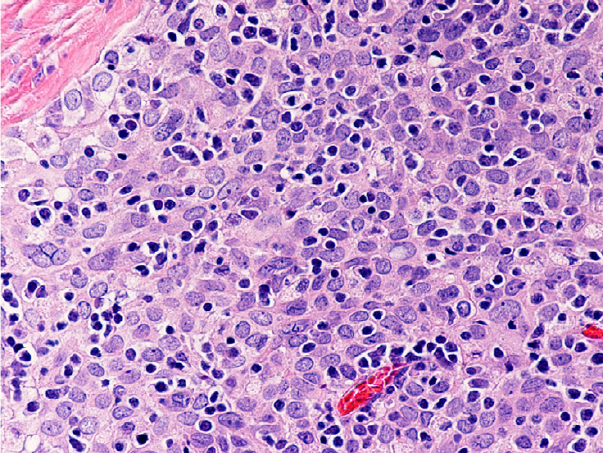
Figure 7 (B-SA, anti-CD20, × 200): Type B3 thymoma associated with myasthenia gravis.